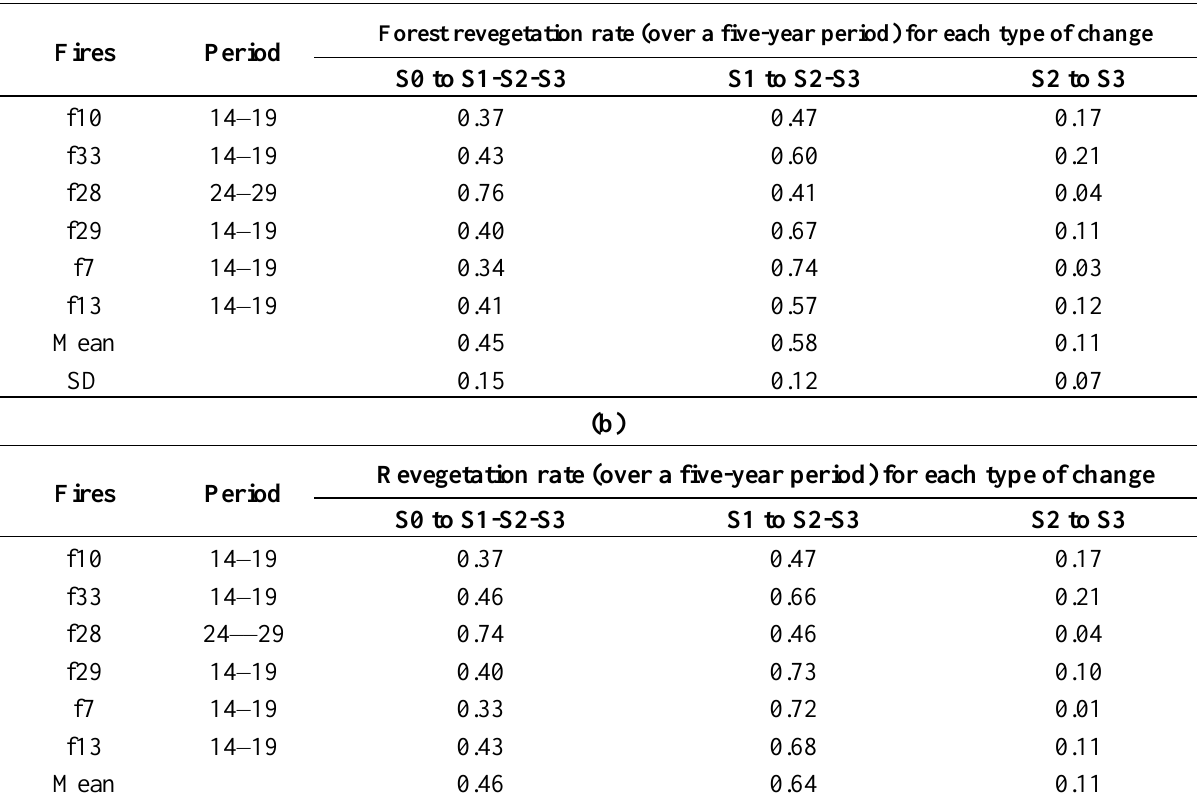
Table 3. Comparison of revegetation rate (over a five-year period) between burned (14 to 29 years old) ( a ) for the entire area of fire events, ( b ) for the fires that burned only in the mature forested portion, and ( c ) harvested (10 to 25 years old) agglomerations. Means and standard deviations (SD) are included for each type of